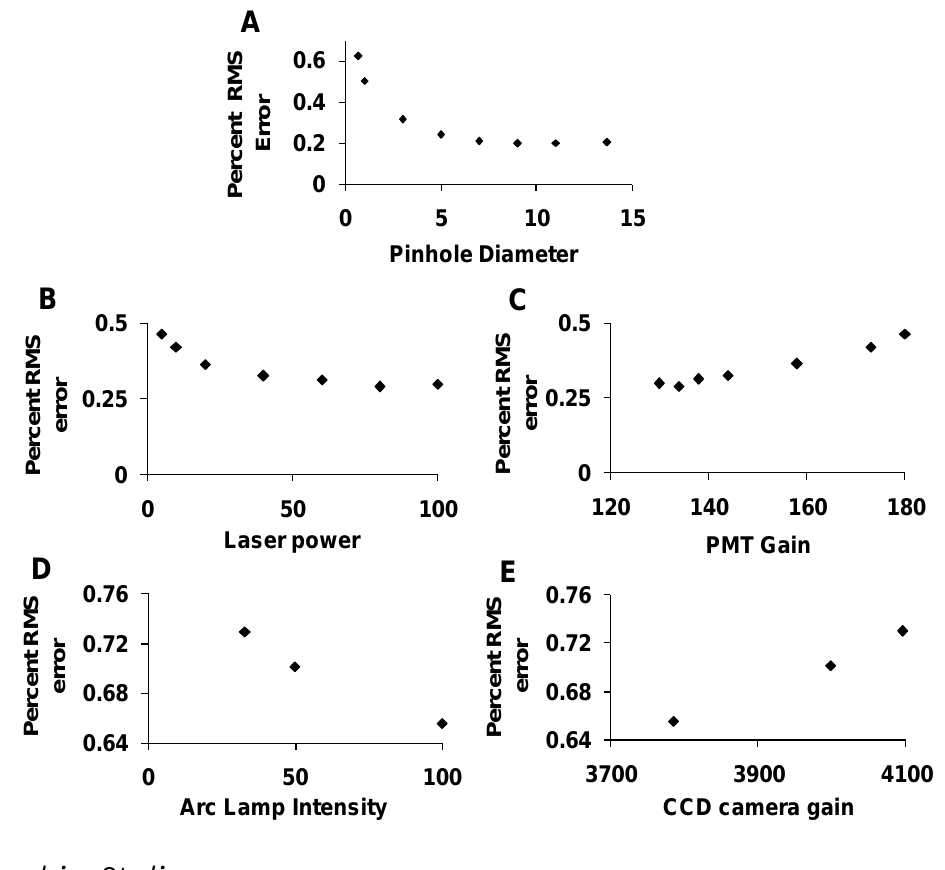
Figure 9. Effect of confocal pinhole diameter ( A ); confocal laser power ( B ); confocal photomultiplier tube (PMT) gain ( C ); widefield arc lamp intensity ( D ); and widefield electron-multiplied charge coupled device (EMCCD) camera gain ( E ) on the percent root-mean-square (RMS) error from linear